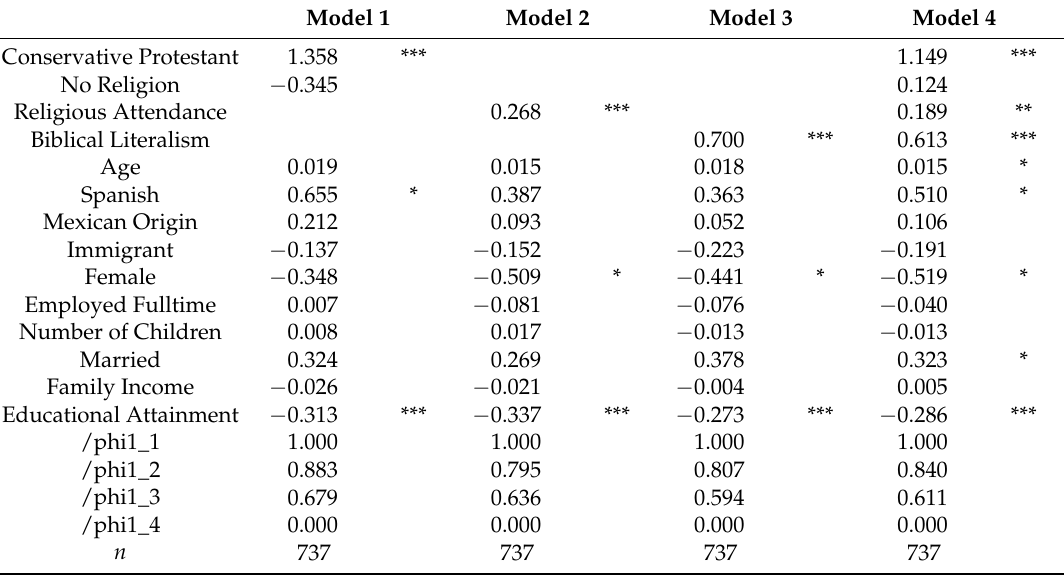
Table 4. Logit Coefficients of Stereotype Regression Models Predicting Male Headship: ‘The Husband Should Be the Head of the